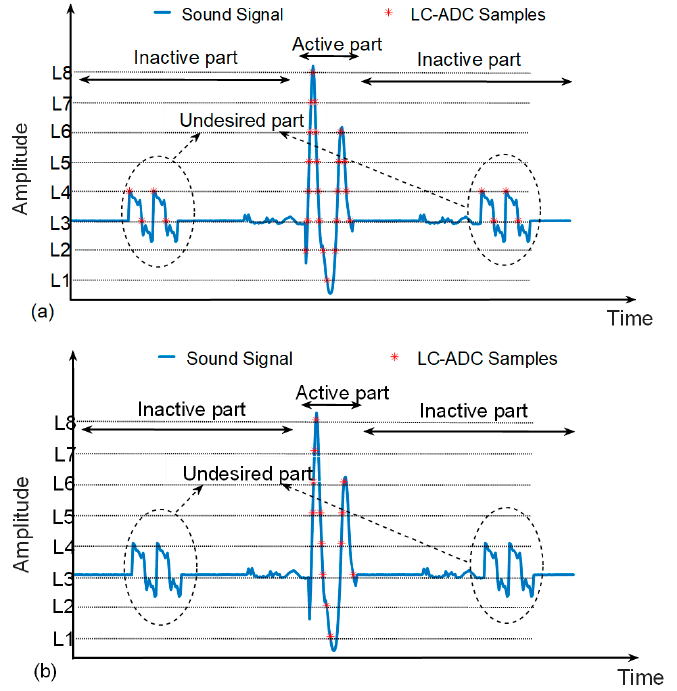
Figure 4. Effect of increasing the K on level-crossing sampling: ( a ) K = 2 LSBs, ( b ) K = 4 LSBs.